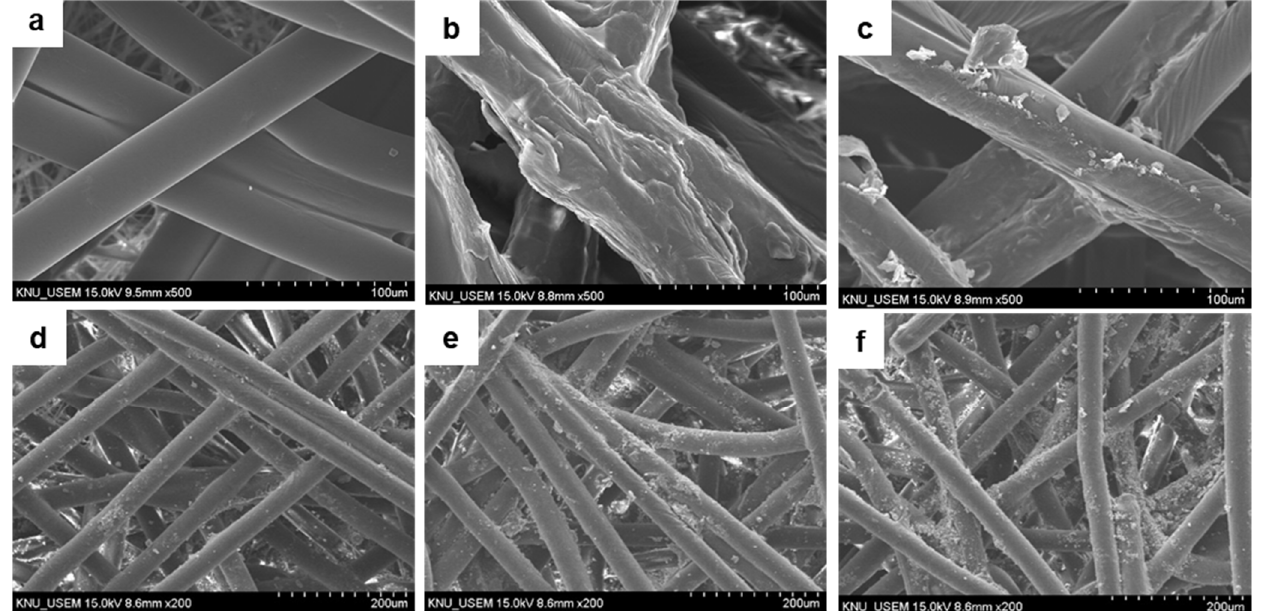
Figure 4. SEM images of: ( a ) pristine NWPF, ( b ) pretreated NWPF, ( c ) SiO 2 -coated NWPF, ( d ) 1% PNT-coated NWPF, ( e ) 2% PNT-coated NWPF, and ( f ) 5% PNT-coated NWPF. Table 1. Photocatalyst weight content on non-woven polymer fabric in detachment